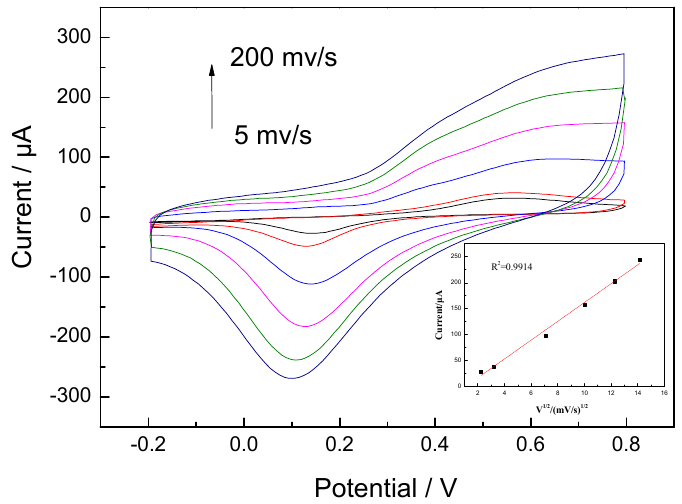
Figure 6. CVs recorded the GOx/HTNTs/Ti electrode at different scan rates in PBS (pH = 7.4) containing 5 mM glucose. The inserted graph showed the relationship between the peak current under the potential of +0.55 V and the square root of scan rates .